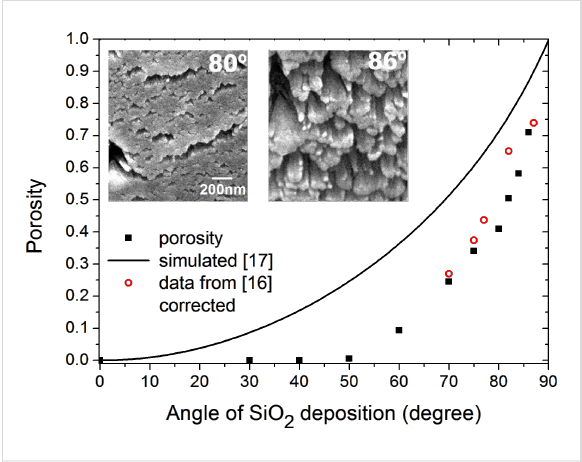
Figure 2: Porosity of SiO 2 films vs angle of deposition (filled squares). Also shown are corrected data from [16] (empty circles) and the curve simulated in [17]. The inset shows FESEM top-view images of SiO 2 samples for α = 80° and α = 86°. Yang et al. [16] calculated the film porosity from the measured isotropic refractive index n using the formula